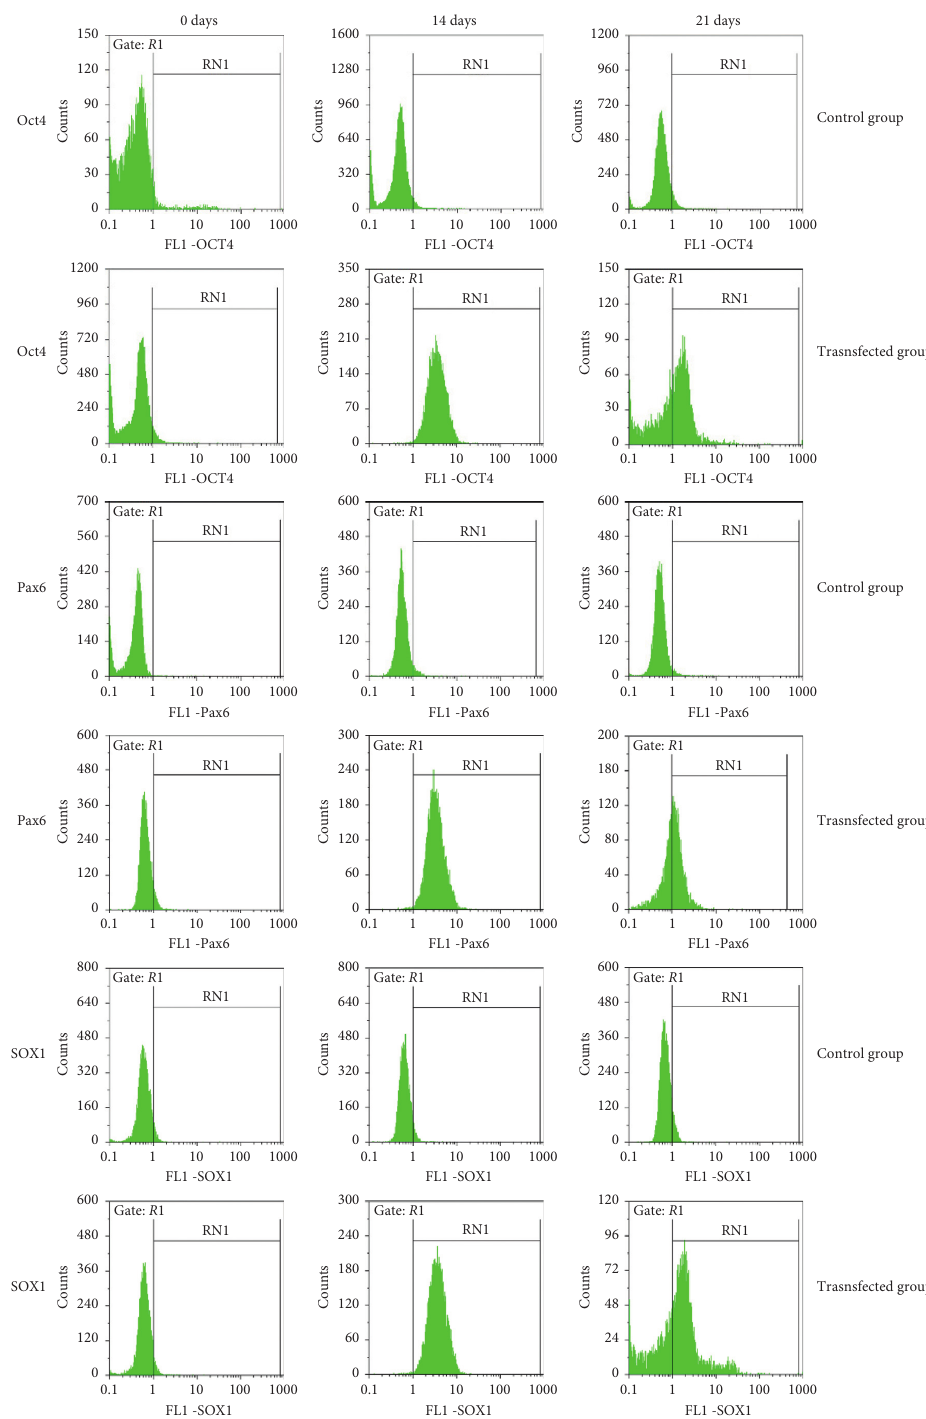
Figure 5: Flow cytometry revealing Oct4, Pax6, and SOX1 expressions of NSC markers increased at 14 days of incubation and gradually decreased again at 21 days of incubation. Oct4, octamer-binding protein; Pax6, paired box gene 6; SOX1, sex determining region Y-box 1; NSC, neural stem